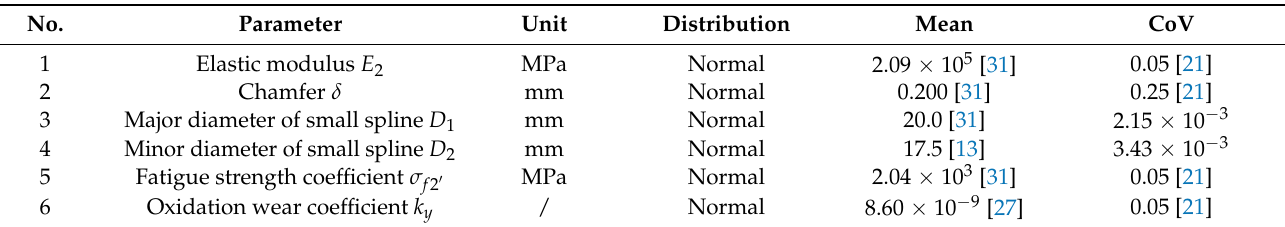
Table 3. Statistical information of the design parameters of the spline shaft.